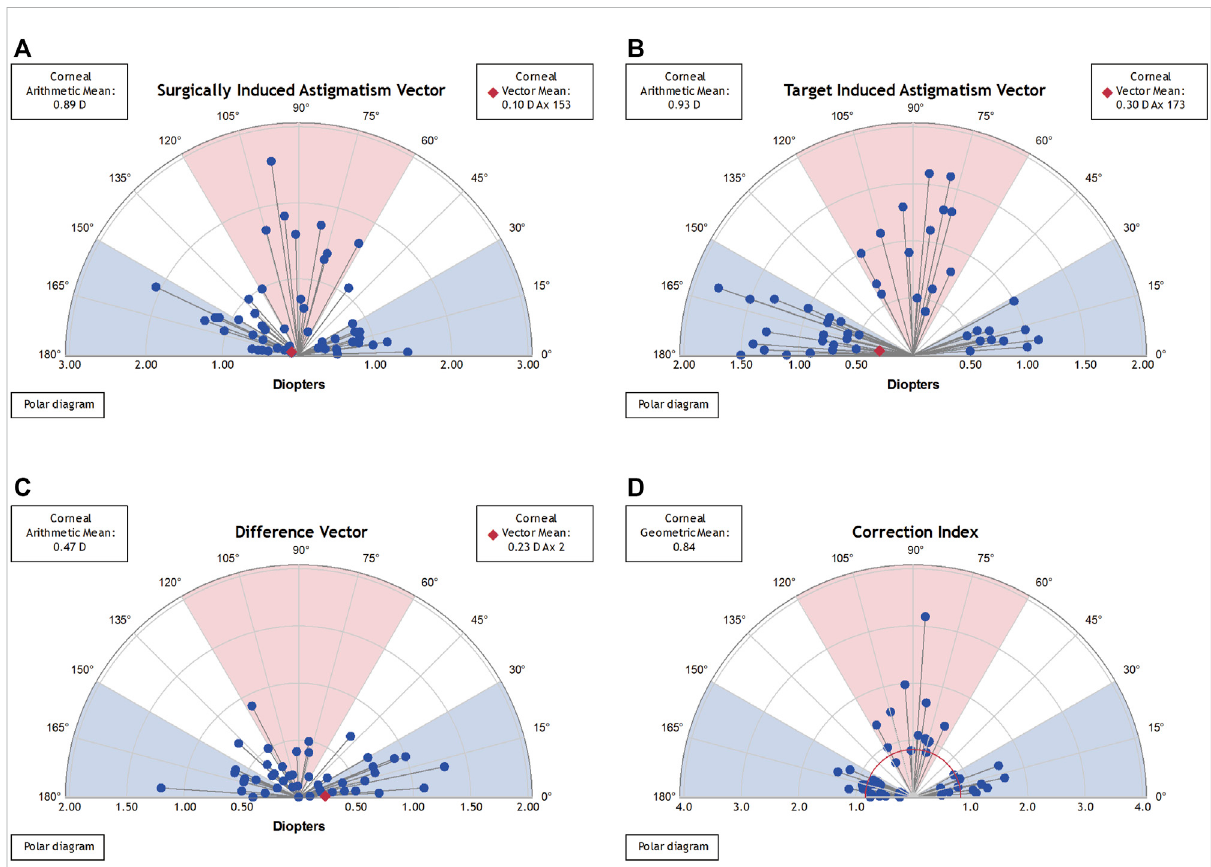
FIGURE 4 Single-angle polar plots for paired FSAK group. The vector average values were plotted in the form of a red diamond (estimated using the double-anglevectorspace)andtheSDvaluesforthe X and Y axeswerepresentedinacall-outbox. (A) .SIAvector; (B) .TIAvector; (C) .DV;and (D) .CI.